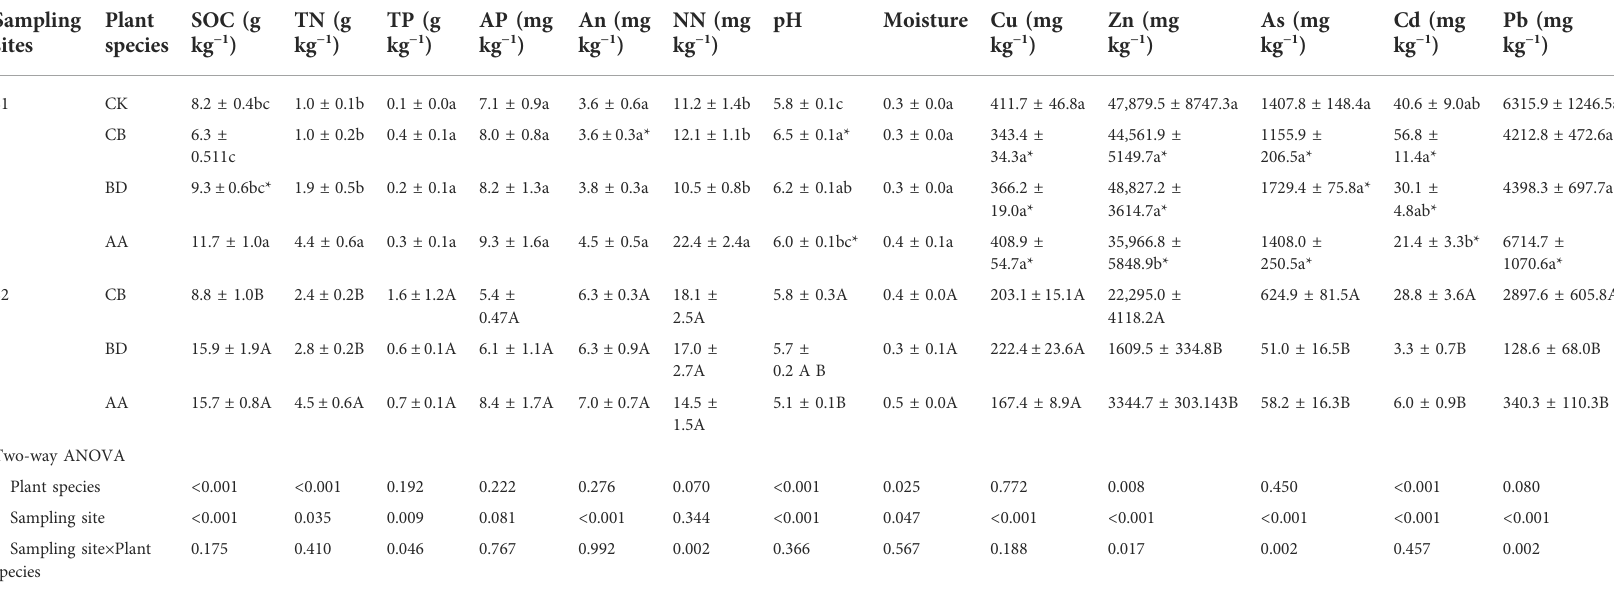
CB, BD, and AA respectively represented C. breviculmis , B. davidii , and A. annua . S1, sample site on the zinc smelter waste heap; S2, sample site around the zinc smelter waste heap. Mean values (mean ± se, n = 4) followed by different lowercase letters presented signi fi cantdifferences of sampled soilscollected onthezincsmelter wasteheap(S1), by different capitallettersrepresentsigni fi cantdifferences ofsampled soilscollected nearthezinc smelter wasteheap (S2). SOC,soilorganiccarbon;TN,